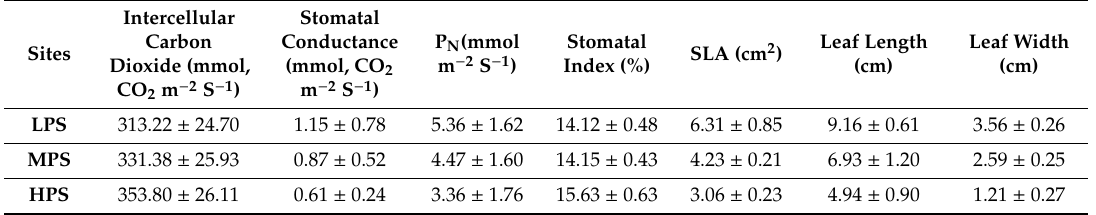
Table 1. Functional stomatal characteristics and Leaf attributes of P. dulce at three sites.